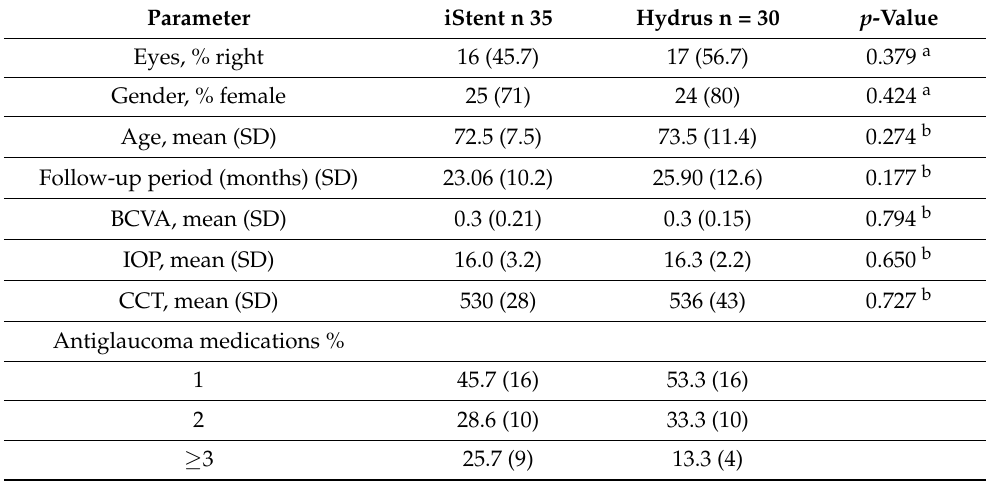
Table 1. Demographic and baseline characteristics of eyes meeting the